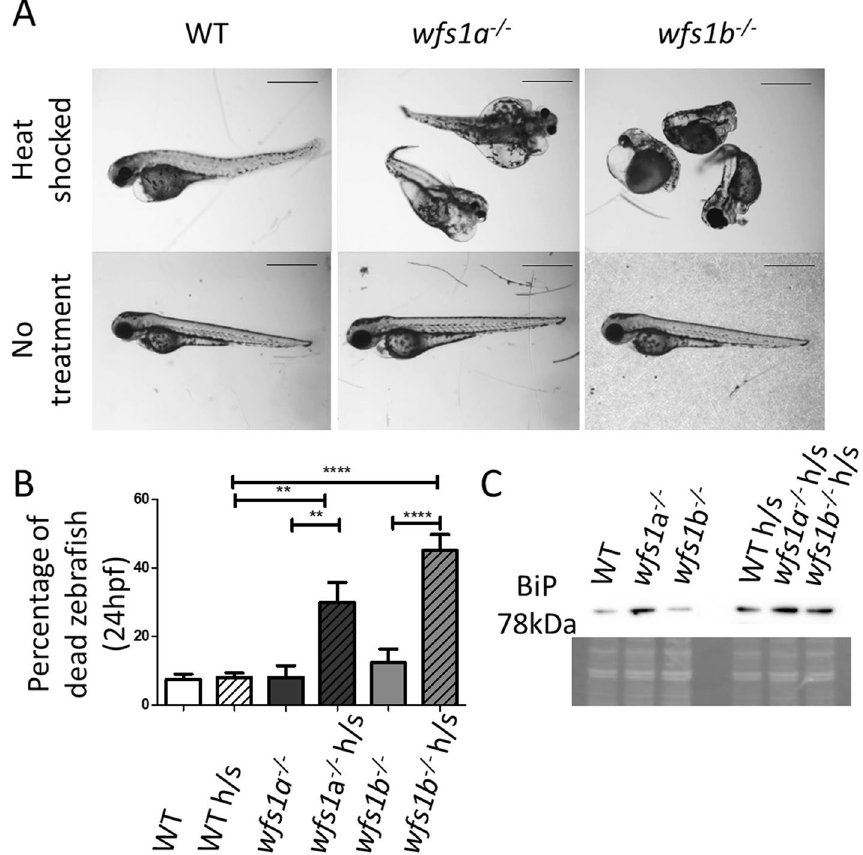
Figure 2. Effects of the unfolded protein response in wfs1a −/− and wfs1b −/− zebrafish. Treated zebrafish were heat shocked for 1 h at 6 hpf (groups of 50 embryos). ( A ) Representative images of the morphological effects for each genotype at 80 hpf. Scale bar = 1 mm. ( B ) Percentage of dead zebrafish at 24 hpf. Data plots represent mean ± SEM (n = 5 groups of 50). Statistical significance was determined by One-Way ANOVA with Bonferroni multiple comparisons. ( C ) Immunoblot of BiP in untreated and heat shocked zebrafish showing an upregulation of BiP in response to heat shock. Coomassie staining demonstrates equal loading. *p < 0.05; **p < 0.01; ****p < 0.0001; h/s: heat shock